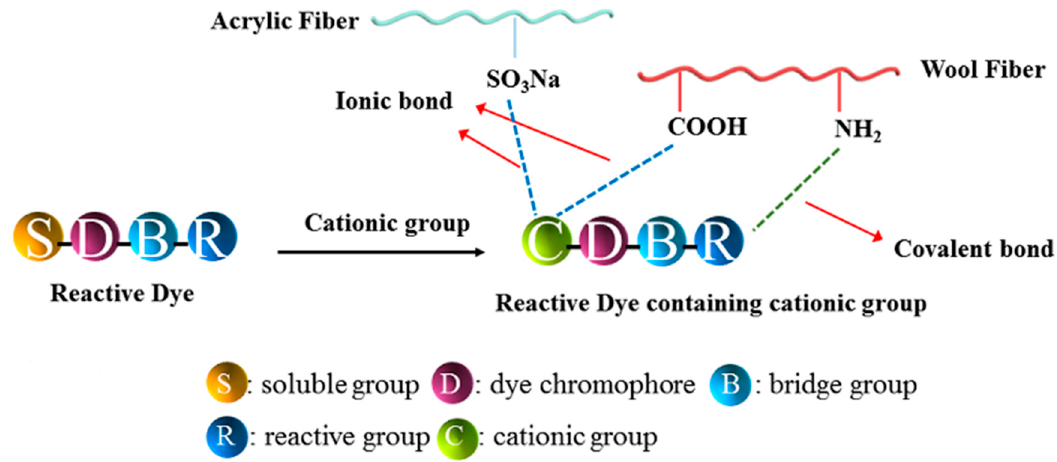
Figure 1. The mechanism between reactive dye with blended fabric.